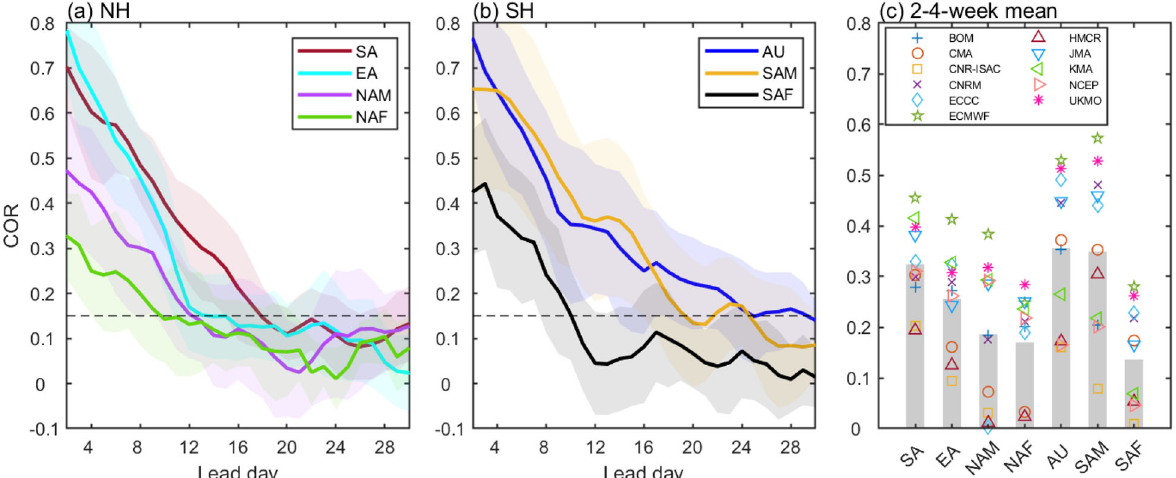
Fig. 8 Divergent sub-seasonal prediction skills over individual summer monsoons. Correlation between observed precipitation anomalies (in CPC data) and multi-model ensemble mean of 11 S2S prediction models ’ hindcasts averaged over the wet regions of the leading ISV modes (precipitation anomalies above 0.05 mm day − 1 in Fig. 3a) for a NH and b SH summer monsoons. Correlations are calculated from leading 2 to 30 days for the hindcasts initialized around the 1st, 10th, and 20th of each month during the summers of 1999 – 2010. Shading indicates one standard deviation among the 11 S2S models and dotted lines denote correlation signi fi cant at the 90% con fi dence level. c shows the correlation of weekly precipitation anomalies averaged from Week 2 to Week 4 for multi-model ensemble mean (bar) and each model